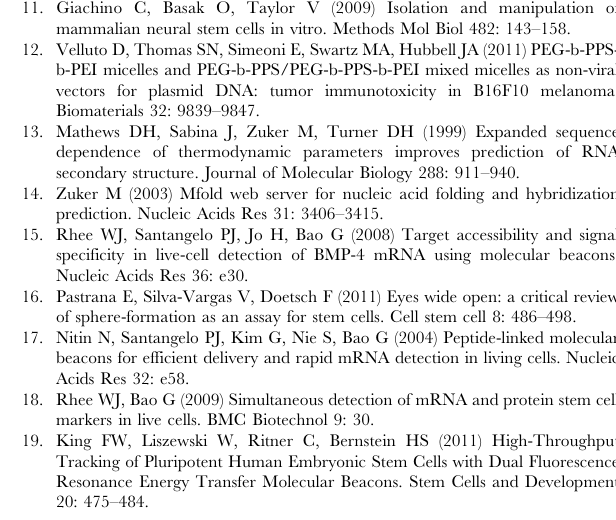
cells were treated with Sox2- MB1 (blue line), Sox2- MB2 (green line), Sox2- MB3 (orange line), Sox2- MB4 (cyan line) and nonspe- cific-MB (red line). Figure S2 Microscopy of living mES cells treated with Sox2- MBs with phase and fluorescent images. mES cells were treated with (A,B) Sox2- MB1, (C,D) Sox2- MB2, (E,F) Sox2- MB3, (G,H) Sox2- MB4 and (I,J) nonspecific-MB. Scale bar = 200 m m. Figure S3 Sox2 -MB delivered with Lipofectamine-2000 to mES cells. Fluorescent signals of mES cells treated with Sox2 - MB (blue line) and nonspecific-MB (control, red line) as measured by flow cytometry. Figure S4 Confocal microscopy of Oct4-GFP mES cells treated with Sox2 -MB. (A) Living Oct4-GFP mES cells treated with the Sox2- MB with orthogonal slices in the xz-plane and yz- plane are shown. (B) As a control, living Oct4-GFP mES cells treated with the nonspecific-MB with orthogonal slices in the xz- plane and yz-plane are shown. Scale bar = 20 m m.